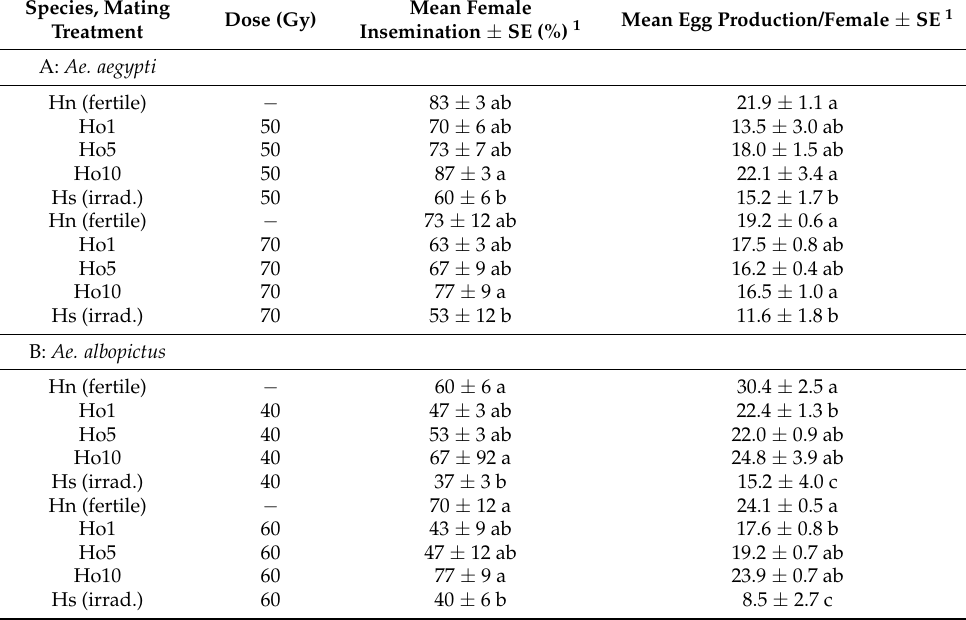
Table 2. Mean percentage of insemination of (A) Aedes aegypti and (B) Aedes albopictus females in field cages subjected to different mating treatments and egg production in mated females recovered from cages. Males were irradiated in the pupal stage with one of two doses of irradiation or were fertile male controls